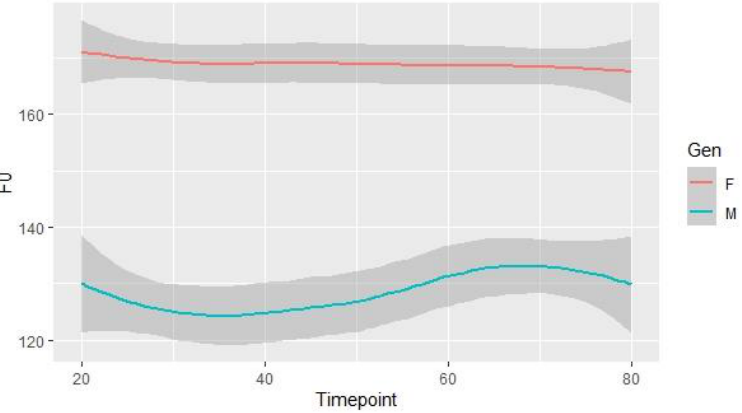
Figure 6. HM F0 contours (female = red, male = blue).